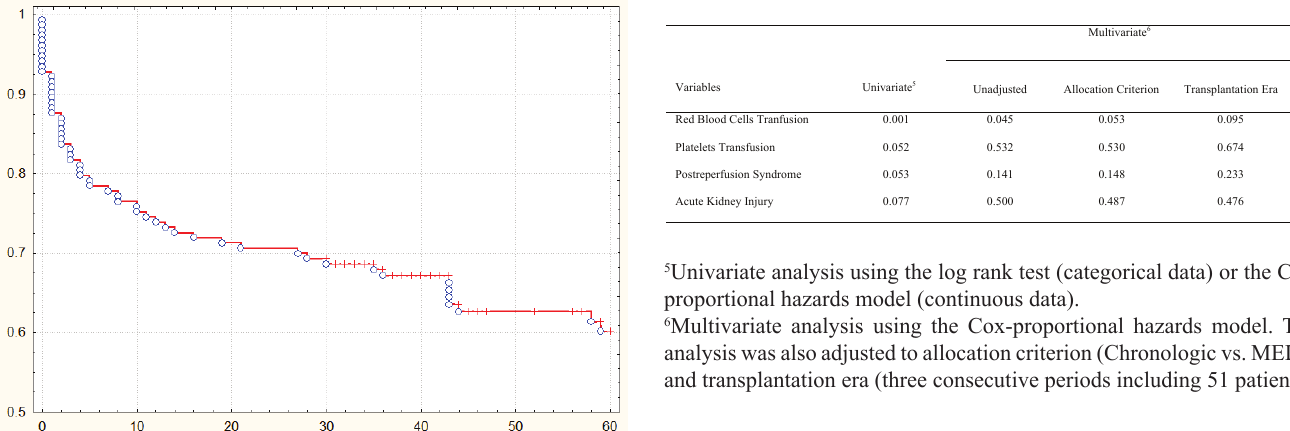
TABLE 3 - Multivariate